Question: Author a descriptive caption for the visualization shown.
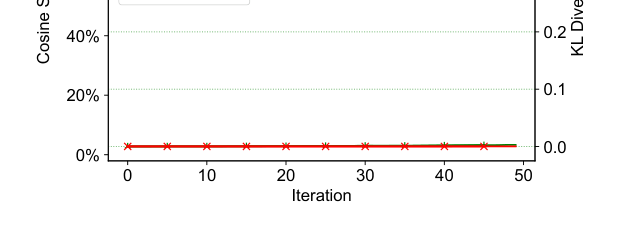
Answer: Information leakage of partial encryption through the whole sampling process. Cosine similarity and KL diver- gence between two latent-space images are used to evaluate the effect of information preservation. The blue line and the green line denote cosine similarity. The cosine similar- ity between the encrypted portion and the original image is approximately 99.96%, compared to 2.81% for the plain- text portion. The KL divergences for the encrypted portion are less than 0.0003, whereas they are at least 0.4693 for the plaintext portion. Threshold is set as 0.01.